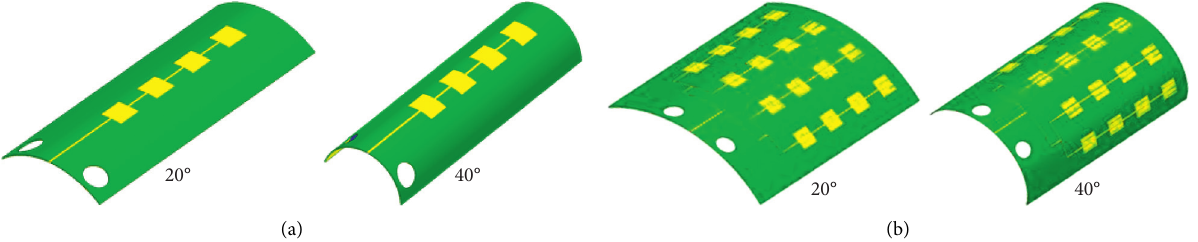
Figure 16: Illustrations of the folding of (a) 4 × 1 subarray and (b) 4 × 4 patch